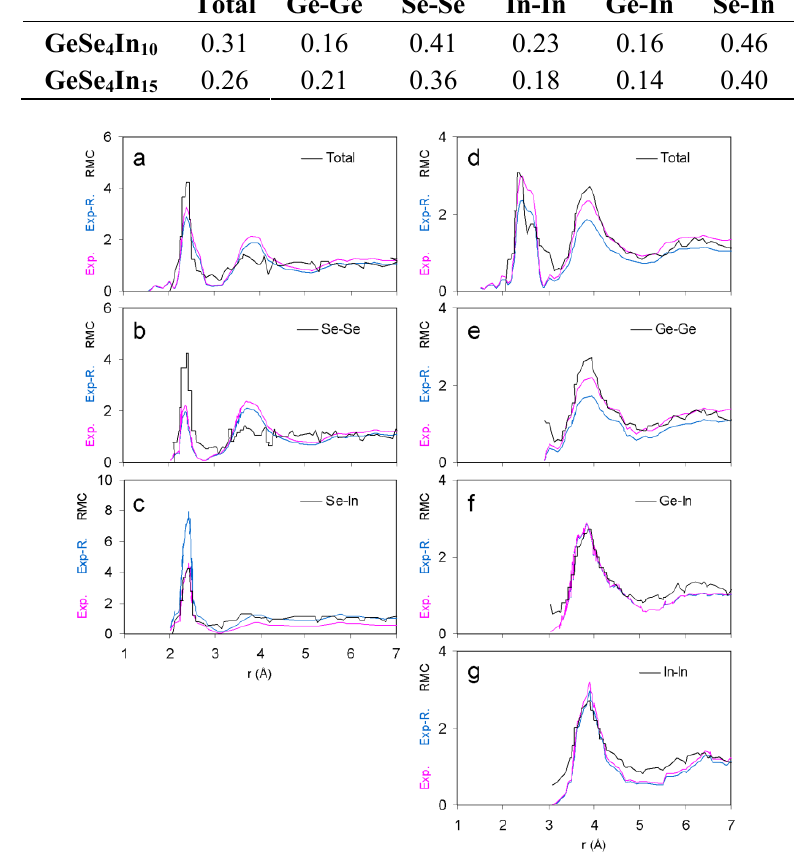
Figure 1. A comparison of RMC-derived vs. experimental total and partial pair distribution functions for GeSe 4 In 10 ( a – c ) and GeSe 4 In 15 ( d – g ). Color coding is as follows: experimental data—pink line; renormalized experimental data, blue line; and RMC, black line. Experimental data renormalization factors were: ( a ) 1.132420, ( b ) 1.122437, ( c ) 0.574149 for the GeSe 4 In 10 system and ( d ) 1.266068, ( e ) 1.270162, ( f ) 1.009675 and ( g ) 1.082473 for the GeSe 4 In 15 system. We note that renormalization comprised